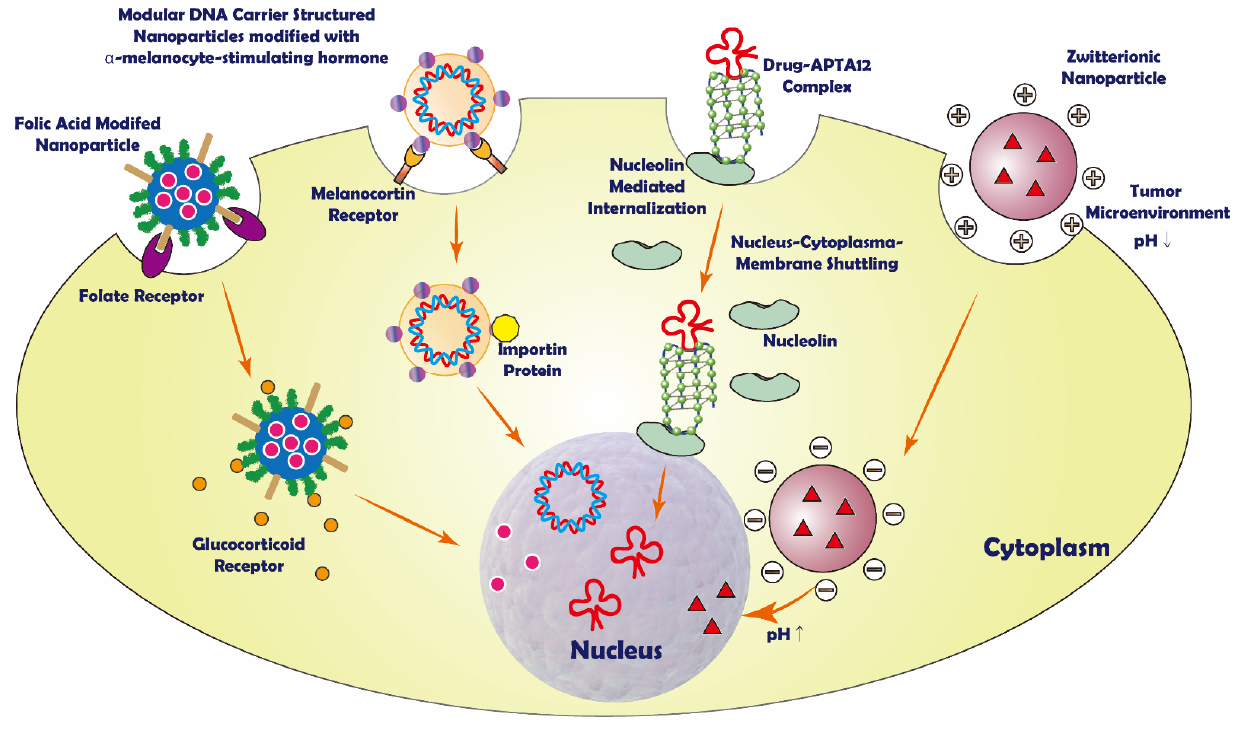
Figure 1. Schematic representation of some sequential nuclear targeting strategies.